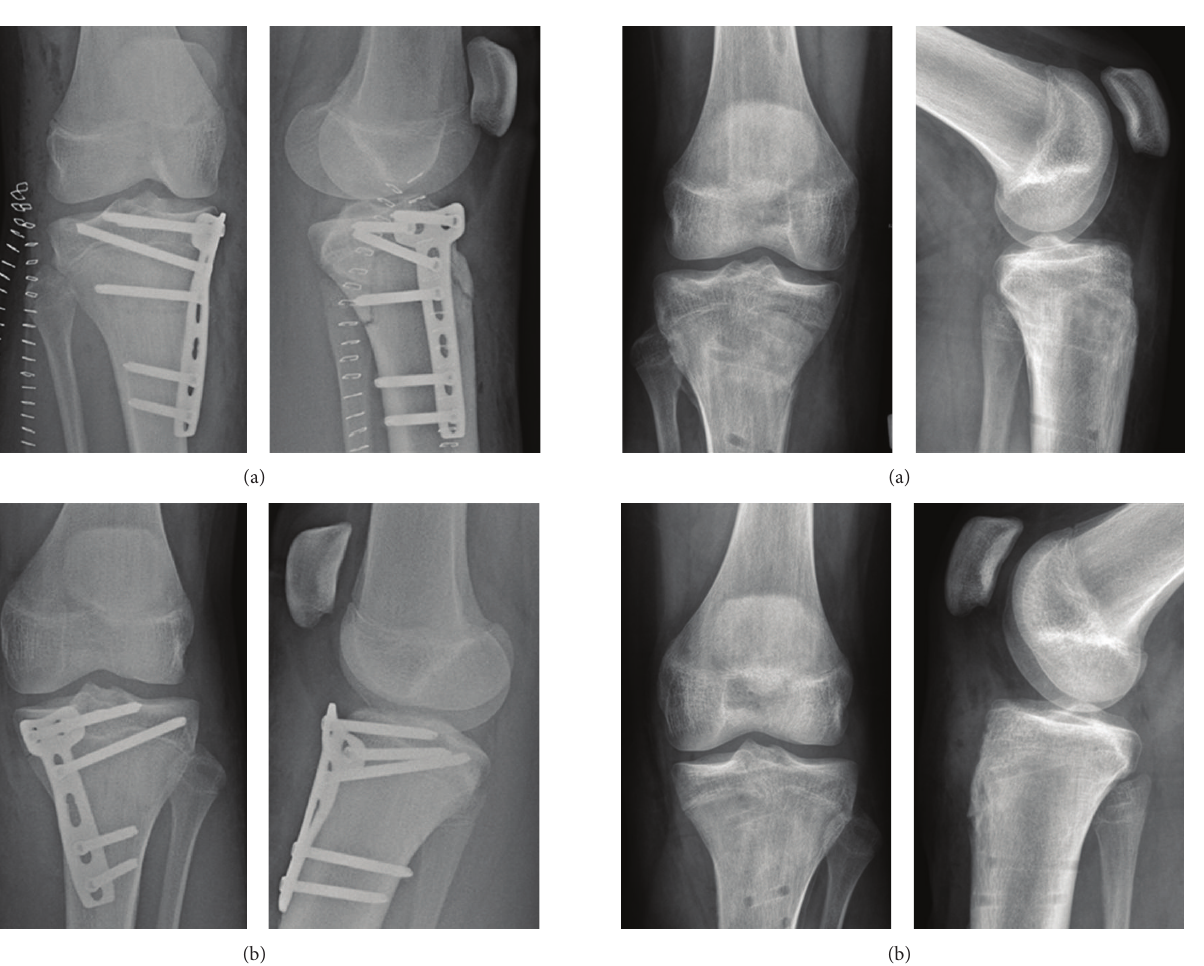
Figure 3: Plain radiographies of the right (a) and left knee (b) following implant removal four months after trauma. Bony healing in anatomic position, growth plates fused.